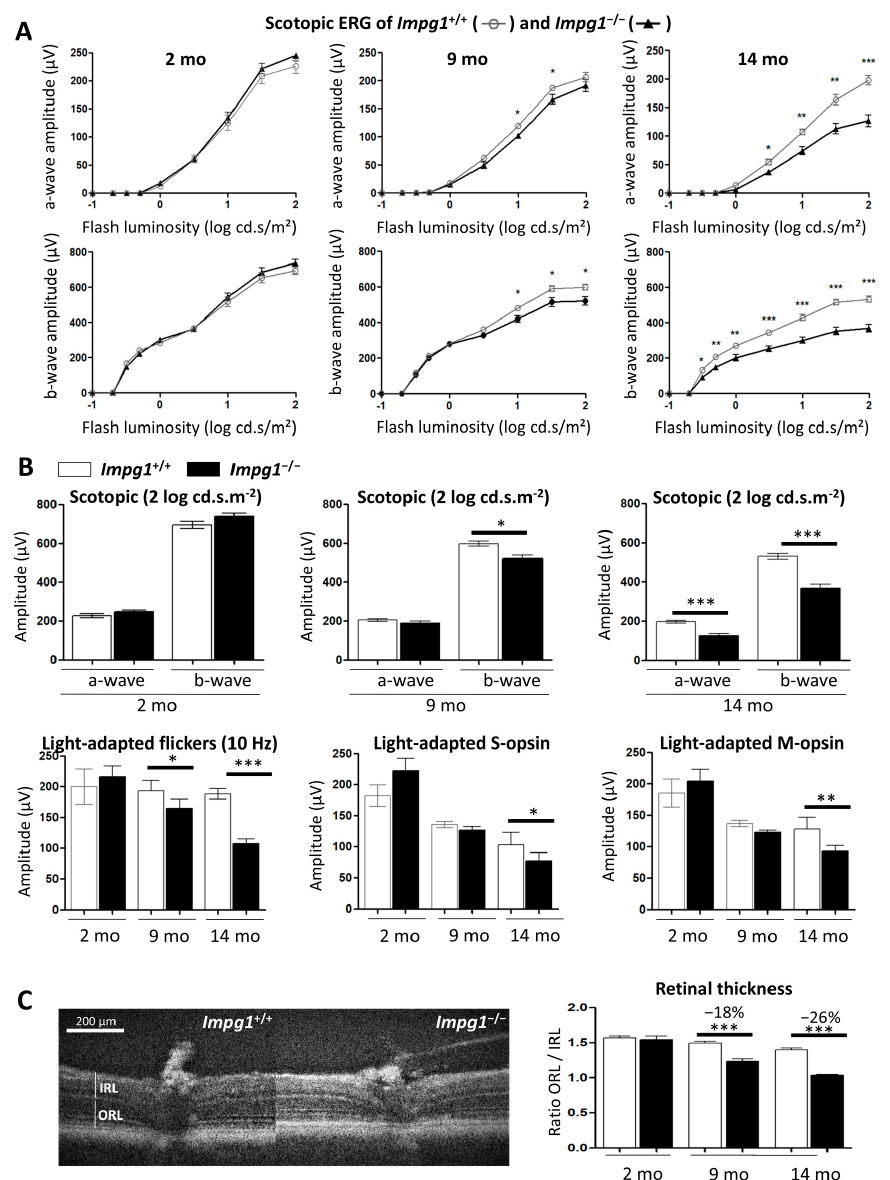
Figure 3. Late functional deficits in rods and cones in Impg1 − / − mice. ( A ) Scotopic ERG response of Impg1 − / − mice (black triangles, thick line) compared to wild-type mice (white circles, thin line) as a function of flash intensity. Bars represent mean ± SEM, n = 6 for each time point (2, 9, and 14 months) and for each condition, with normal distribution, Student’s t -test was used. * p < 0.05, ** p < 0.01, *** p < 0.001. ( B ) IMPG1 knockout (black bar) resulted in reduced amplitudes of the scotopic (upper left panel) and photopic responses at light intensity levels of 2 log cd.s.m − 2 and 10 Hz flicker ERG (upper right panel). Opsin S (blue light) and M (green light) responses are decreased in Impg1 − / − mice (lower panels). Bars represent mean ± SEM, n = 6 with normal distribution; Student’s t -test was used. * p < 0.05, ** p < 0.01, *** p < 0.001. ( C ) SD-OCT analysis of Impg1 +/+ versus Impg1 − / − . Left panel shows the retinal section of a wild-type mouse with annotated layers. The thickness of the inner retinal layer (IRL) and outer retina layer (ORL) were measured for each genotype, and the ORL/IRL ratio was used to evaluate outer retina thickness in wild-type ( Impg1 +/+ , white bars) vs. mutant ( Impg1 − / − , black bars) mice at 2, 9, and 14 months of age (right panels). The ORL/IRL ratio was reduced in Impg1 − / − mice. Bars represent the mean of 10 OCT measurements per animal, 5 animals per group; Student’s t -test; *** p <